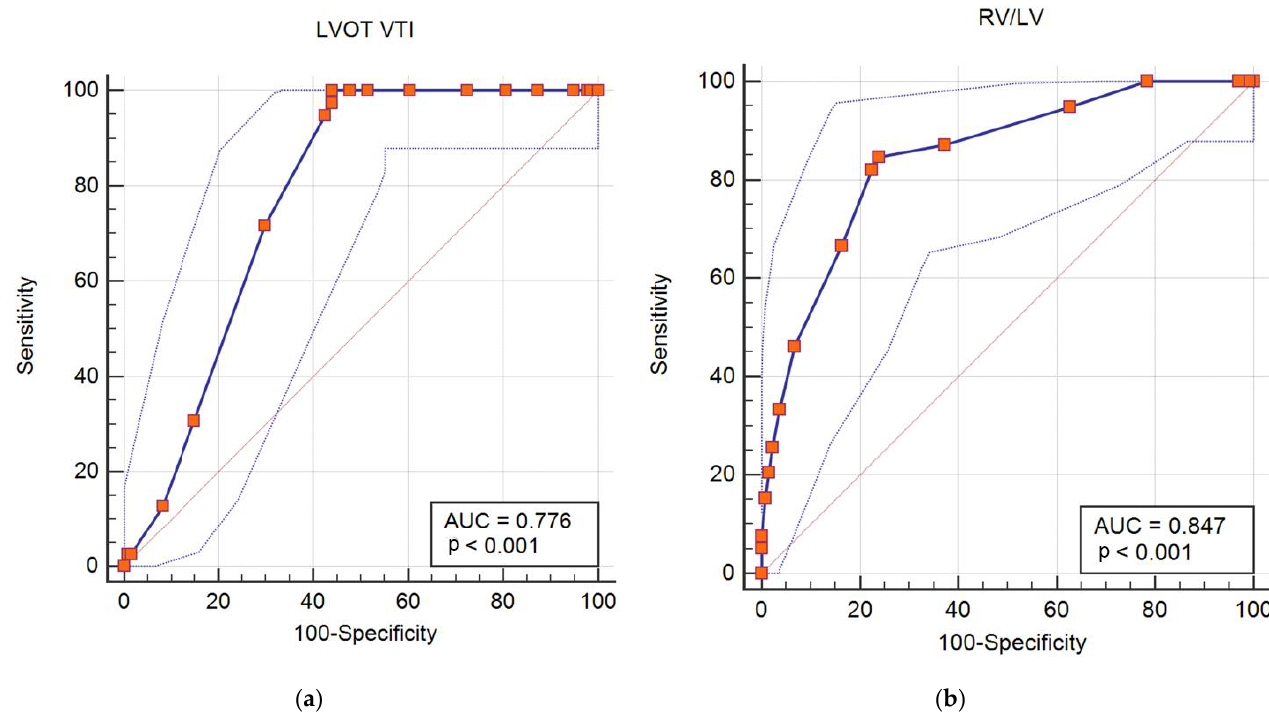
Figure 4. ROC curves for ( a ) LVOT VTI as adverse events predictors in intermediate-high risk PE; ( b ) RV/LV as predictor of adverse events in intermediate-high risk PE. The AUC for an LVOT VTI ≤ 15 cm was 0.767 (95% CI 0.696–0.838) and for